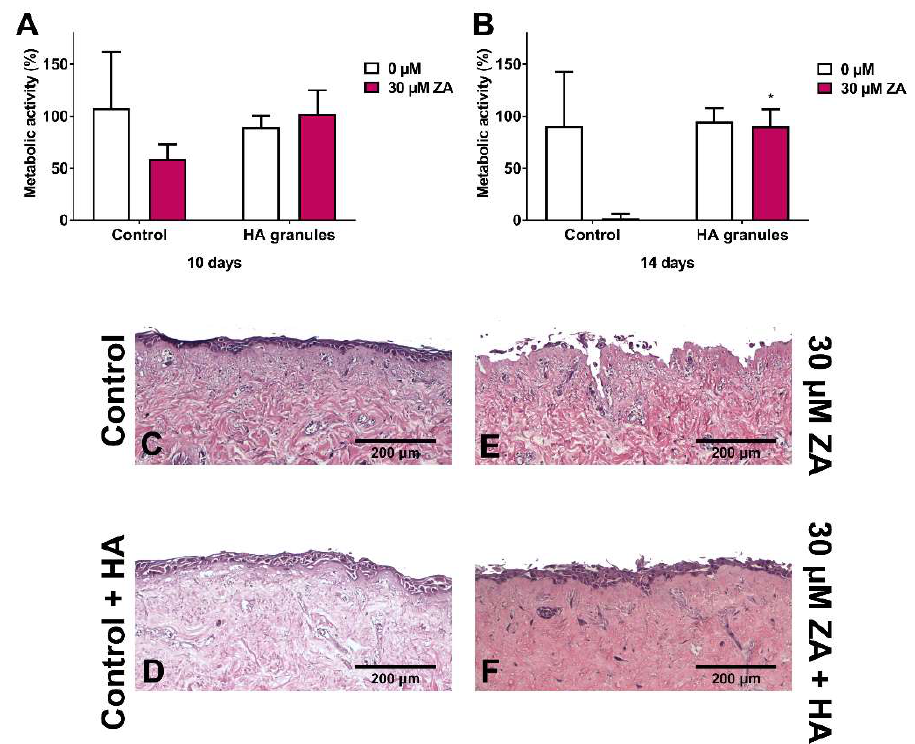
Figure 5. The metabolic activity of oral mucosa models when treated with control medium or 30 µ M zoledronic acid in the presence of hydroxyapatite granules at ( A ) 10 days and ( B ) 14 days. Models with no HA cultured as controls, measured with a resazurin assay. Blank well reading subtracted from values before normalising to day 7 values for each model, defining day 7 values as 100 % (not shown). N = 3, n = 2. Error bars = SD. Statistical significance against control indicated by * p ≤ 0.05. ( C – F ) H & E-stained sections of oral mucosa models seeded with human oral fibroblasts and primary human oral keratinocytes cultured at ALI for 7 days in control medium, then treated with ( C ) control medium, ( E ) 30 µ M zoledronic acid, ( D ) control medium and HA granules and ( F ) 30 µ M zoledronic acid and HA granules, respectively, for 7 days. Representative images used.